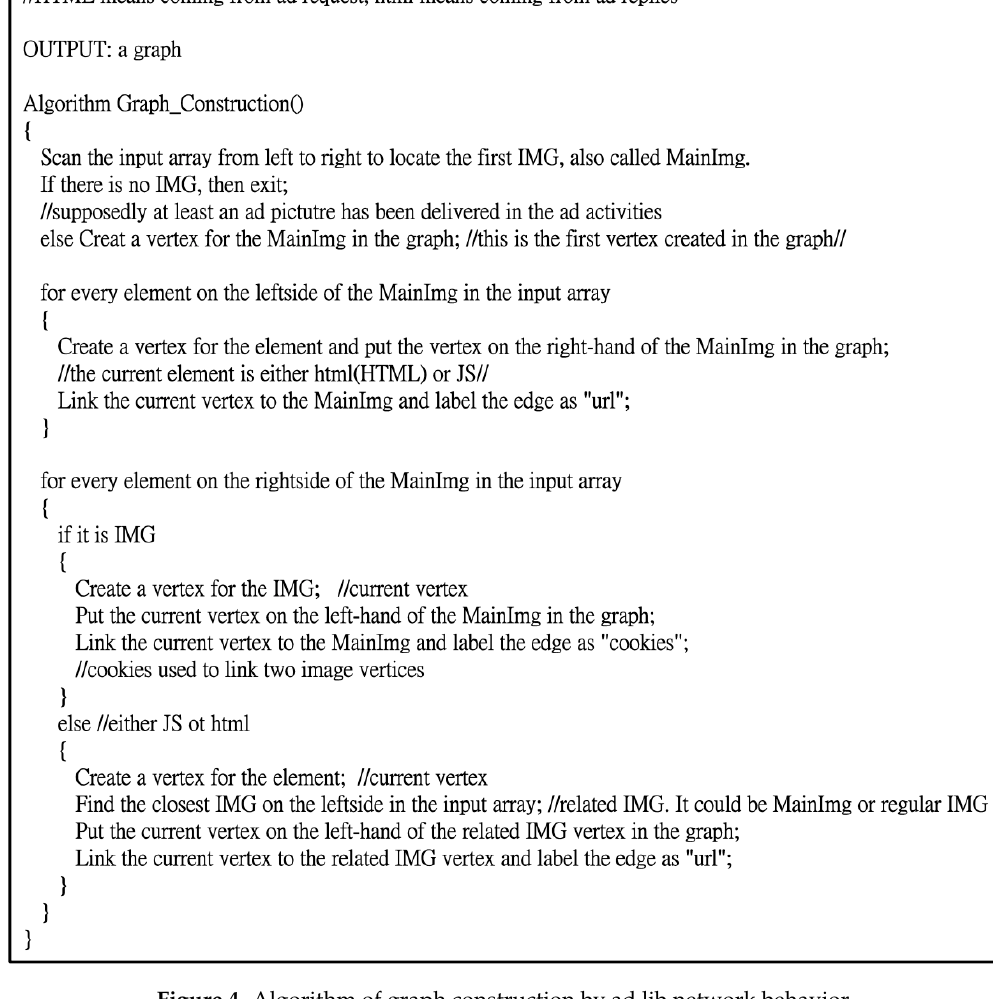
Figure 4. Algorithm of graph construction by ad lib network behavior.